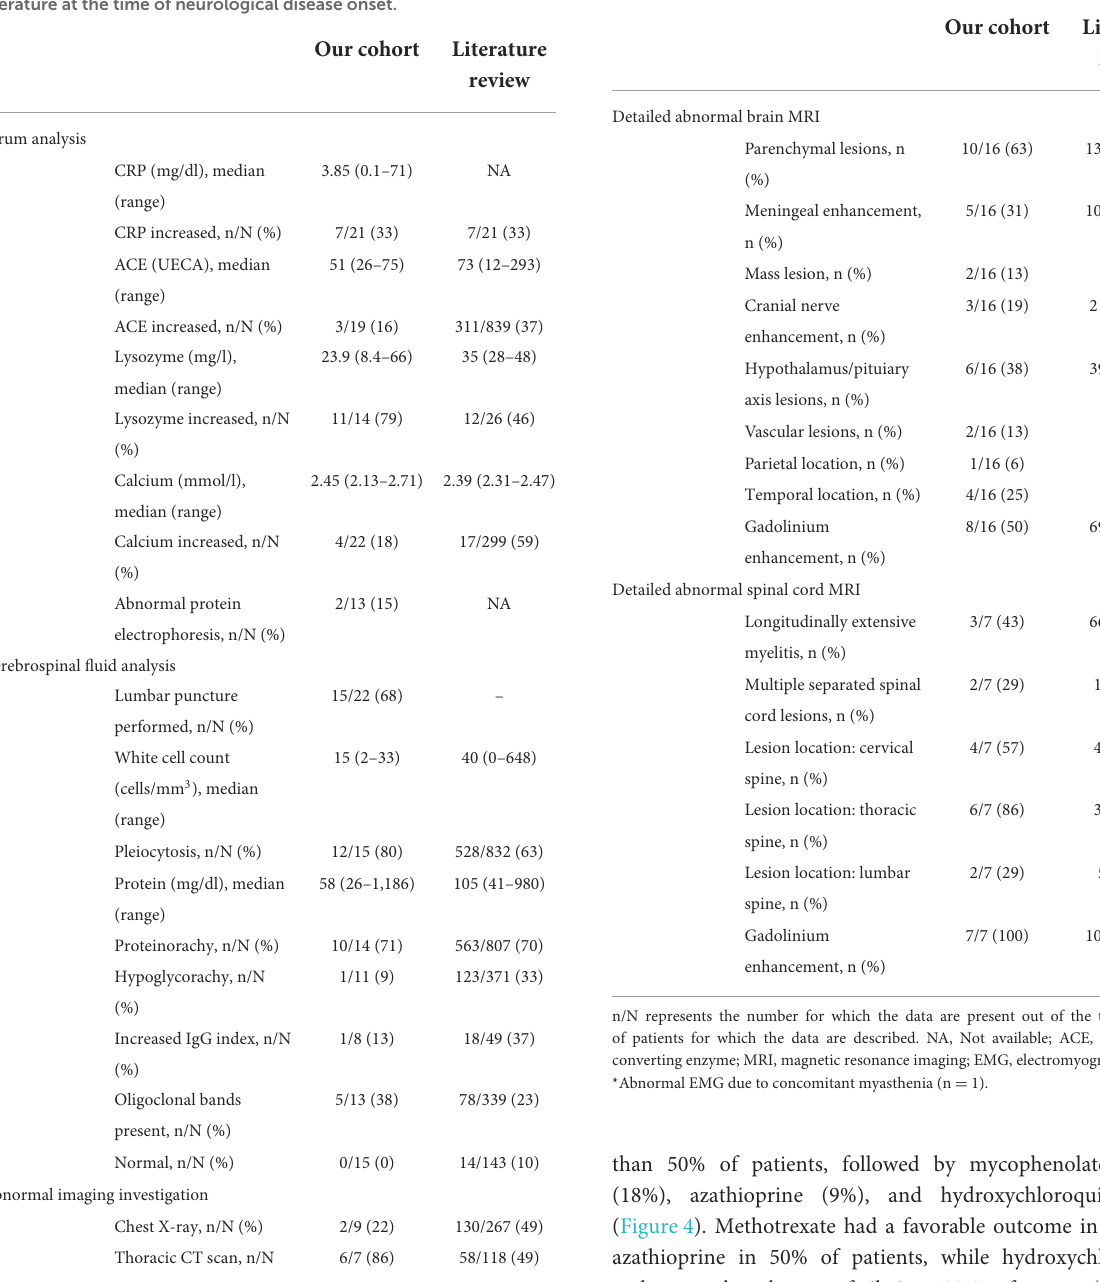
TABLE 3 Paraclinical features of patients from our cohort and the literature at the time of neurological disease